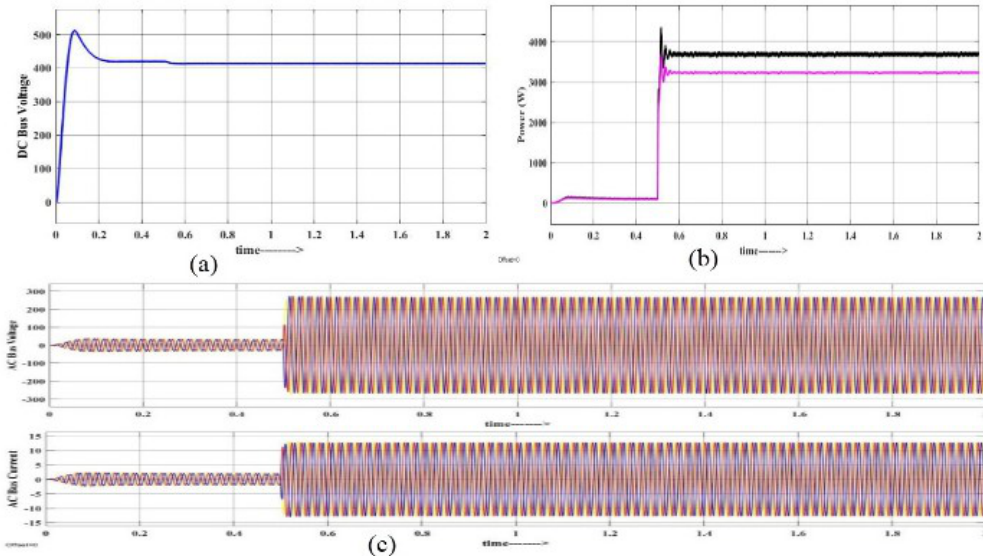
Fig. 8. System Parameters under grid connected mode without controller: (a) DC bus voltage, (b) Grid Power, (c) AC bus voltage and current